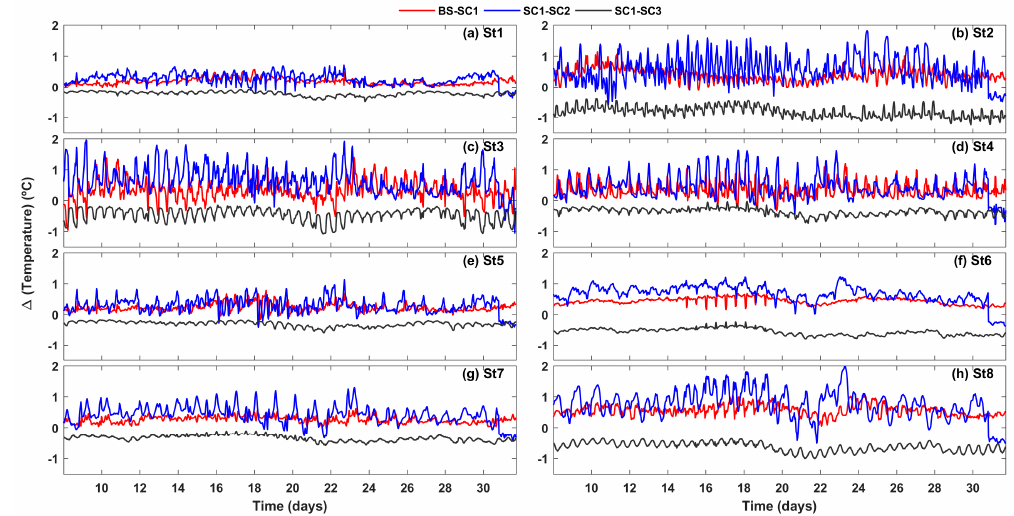
Figure 7. Time series of the water temperature difference, Δ( Temperature), between the scenarios (BS–SC1, SC1–SC2 and SC1–SC3), for September 2000, and the lagoon stations: ( a ) St1, ( b ) St2, ( c ) St3, ( d ) St4, ( e ) St5, ( f ) St6, ( g ) St7 and ( h )